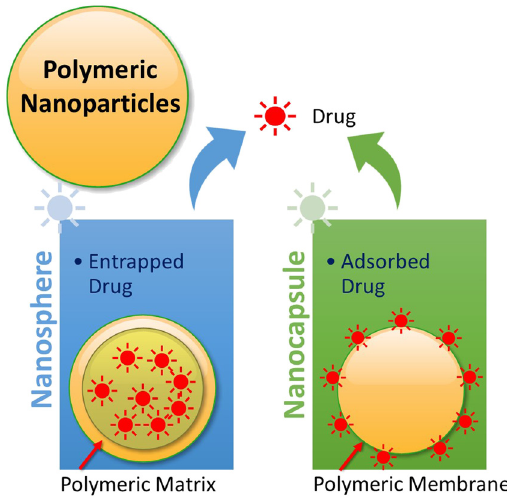
Figure 3: Types of polymeric NPs based on drug loadings.